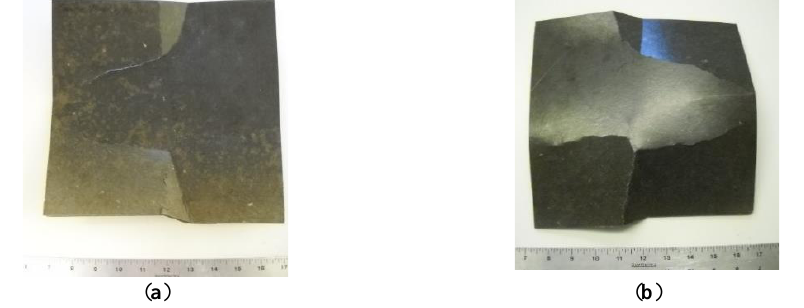
Figure 9. Pre-consolidated blank (after heating and thermoforming). Sample — PA66/CF/78/20, 5 layers of preform; ( a ) exposed side in oven shows much yellowing; ( b ) non-exposed side shows less yellowing.